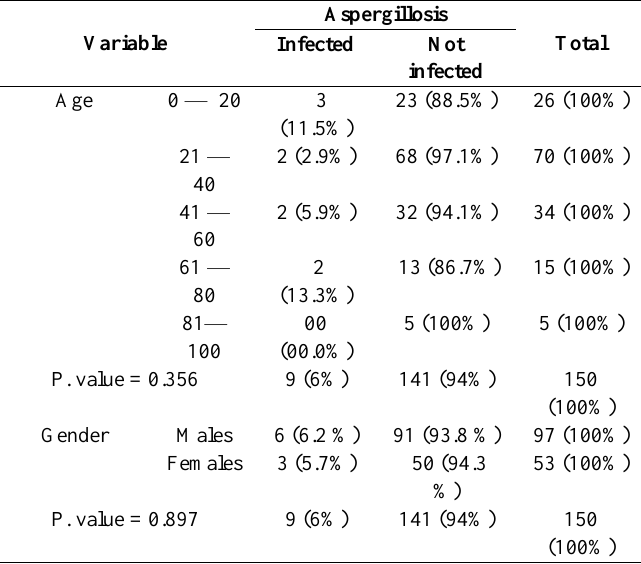
Table 5: Frequency Aspergillosis among the study population according to age and gender